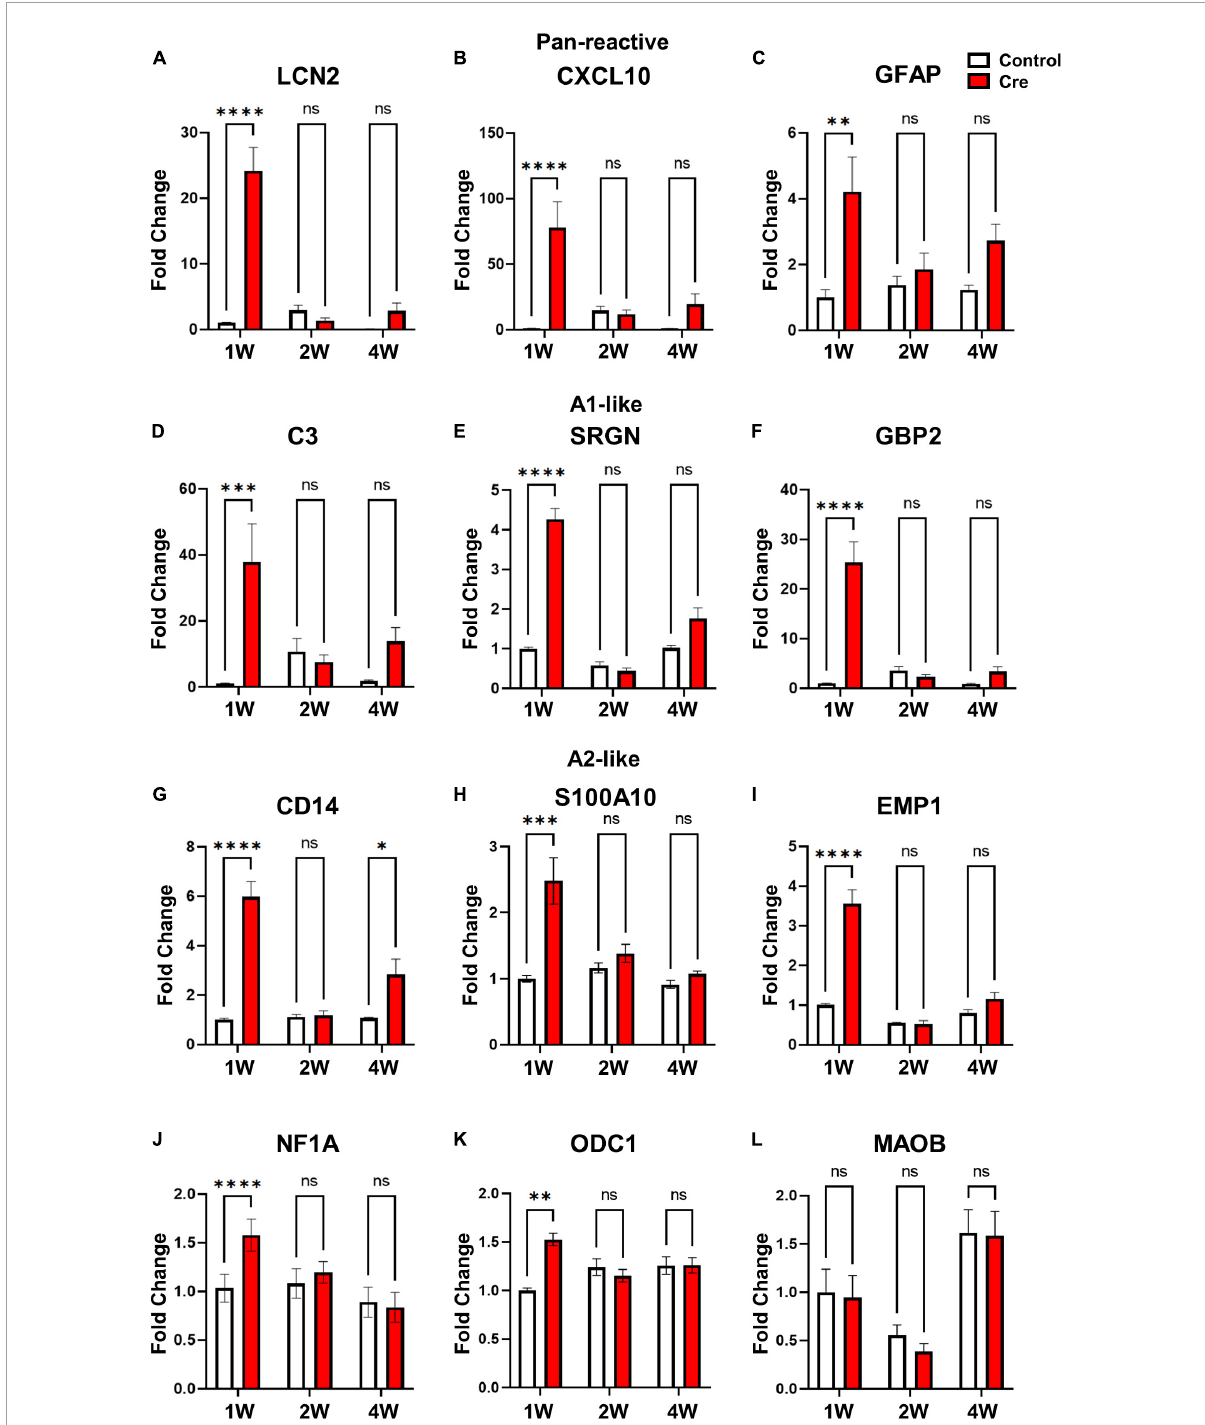
FIGURE3 mRNA Expression of various reactive astrocytic markers in hippocampal astrocyte-specific active caspase-3 cTg mice. mRNA expression of markers of reactive astrocytes using qRT-PCR (# of animals; 1W n = 4, 2W n = 3, 4W n = 3, repeat 3 times). (A–C) Pan-reactive marker; LCN2, CXCL10, GFAP. (D–F) A1-like marker (neurotoxic); C3; complement 3, SRGN; serglycin, GBP2; guanylate-binding protein 2. (G–I) A2-like marker (neuroprotective) ; CD14, S100A10; S100 calcium binding protein A1, EMP1; erythrocyte membrane protein 1. (J) Gliogenesis marker; NF1A (Nuclear factor 1A). (K) Urea cycle; ODC1 (ornithine decarboxylase). (L) Another reactive astrocyte marker; MAOB (monoamine oxidase B). Data are represented as the means ± SEM ( ∗ p < 0.05, ∗∗ p < 0.01, ∗∗∗∗ p < 0.00001 according to two-way ANOVA and Turkey’s test, ns; not